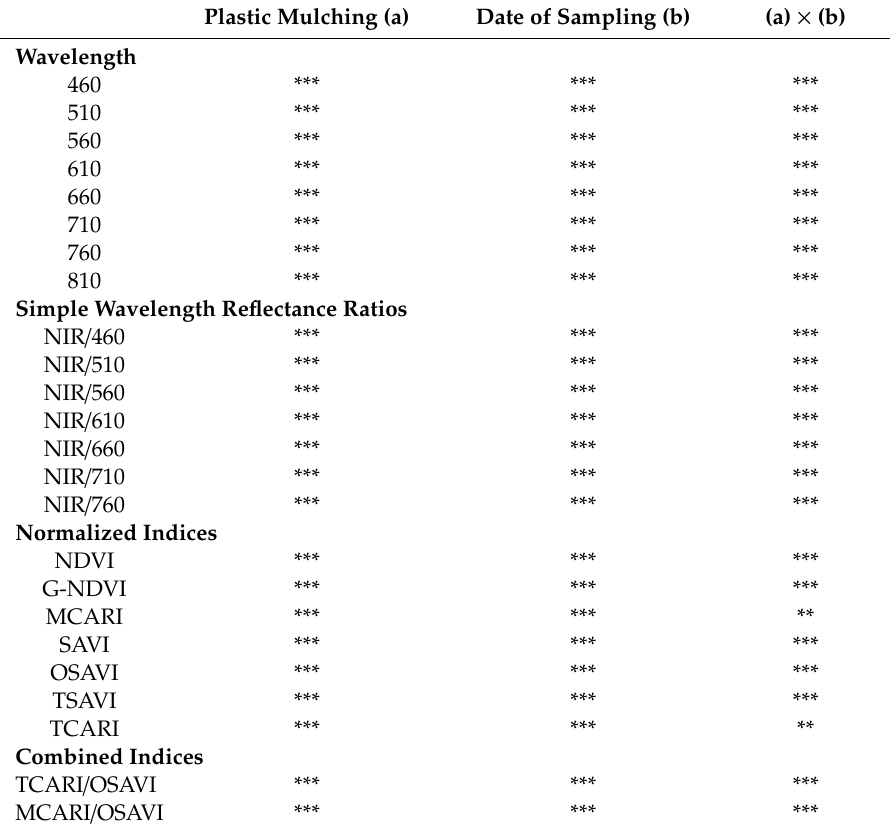
Table 3. Experiment 2#. Statistical significance of each of the factors (plastic mulching, and date of sampling) and of the interaction between factors by ANOVA. * p < 0.05, ** p < 0.01, *** p < 0.001, NS not